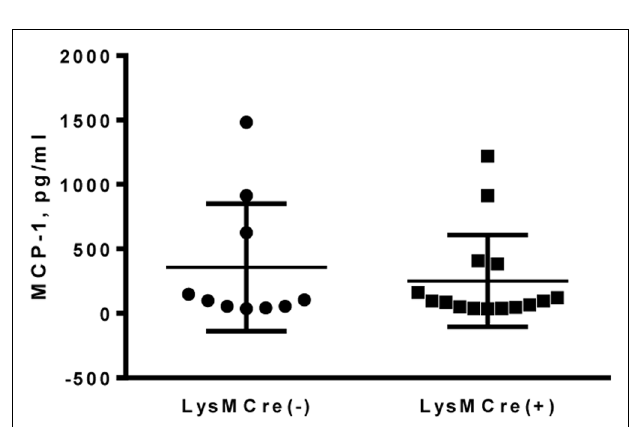
FIGURE 2 | MCP-1-deficiency in myeloid cells did not affect serum MCP-1 concentrations in normal adult mice . Serum was collected from 18- to 20-weeks untreated MCP-1 flox/flox or LysMCre + , MCP-1 flox/flox mice and MCP-1 concentration was measured by ELISA.